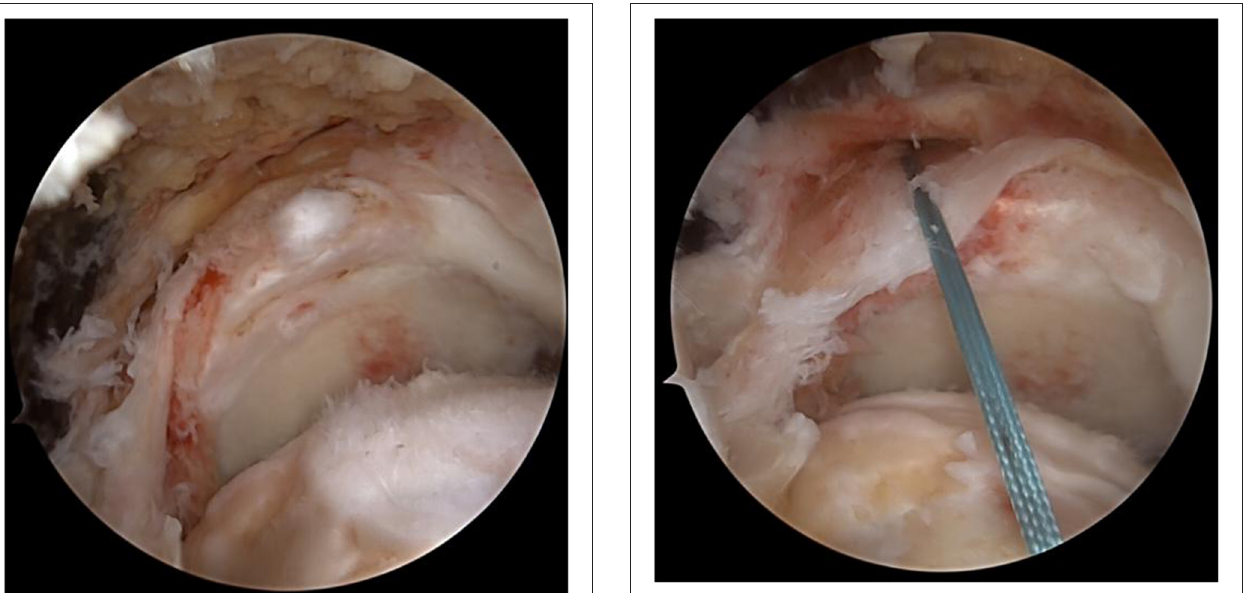
A switching stick was inserted via the anterolateral incision under arthroscopy and passed between the two layers of the infraspinatus tendon and near the lower side of the scapular spine, reaching the subcutaneous layer. A 4-cm transverse incision was made at the tip of the switching stick, and the suture on the tendon autograft was held by a suture fetcher and passed through the same tunnel. The tendon autograft was thereby introduced into the shoulder joint from the posterior side, passing through the insertion site of the infraspinatus and greater tubercle. The loop end of the tendon autograft was tied to the anchor fixating the biceps tendon by the suture left from the last step ( Figures 4 , 5 ). An anchor was fixated at the footprint area of the infraspinatus tendon, with one suture fixing the graft and another one suturing together the retracted infraspinatus tendon and the tendon autograft. The inner margin of the supraspinatus tendon and the tendon autograft were stitched together side by side if tension was allowed ( Figure 6 ). After fixation under arthroscopy, the insertion site of the lower trapezius on the scapular spine was exposed through the posterior scapular incision, dissected, pulled distally, and passed across and stitched to the free end of the tendon autograft. Subsequently, to prevent insufficient autograft tendon tension, traction on the autograft tendon was applied by attaching weight until fixation inside the shoulder joint was completed, the tension on the autograft tendon was assessed under arthroscopy while abducting and adduction the shoulder joint, and the free ends of the autograft were then crossed through the lower trapezius muscle and stitched above tithe LTT procedure was then concluded ( Figures 7 – 9